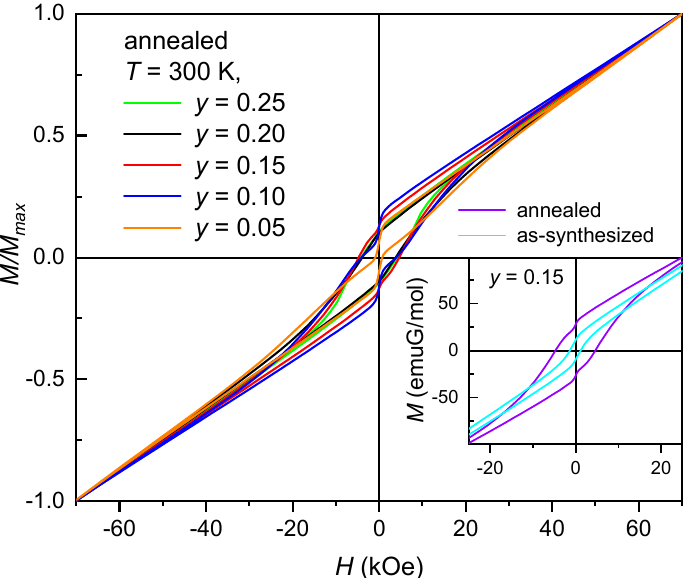
Figure 5. Magnetization loops of the annealed BiFe 1 − y [Zn 0.5 Ti 0.5 ] y O 3 samples measured at 300 K normalized to the magnetization value M max at the maximum applied field. The inset shows the magnetization loop for the composition with y = 0.15 before and after annealing.